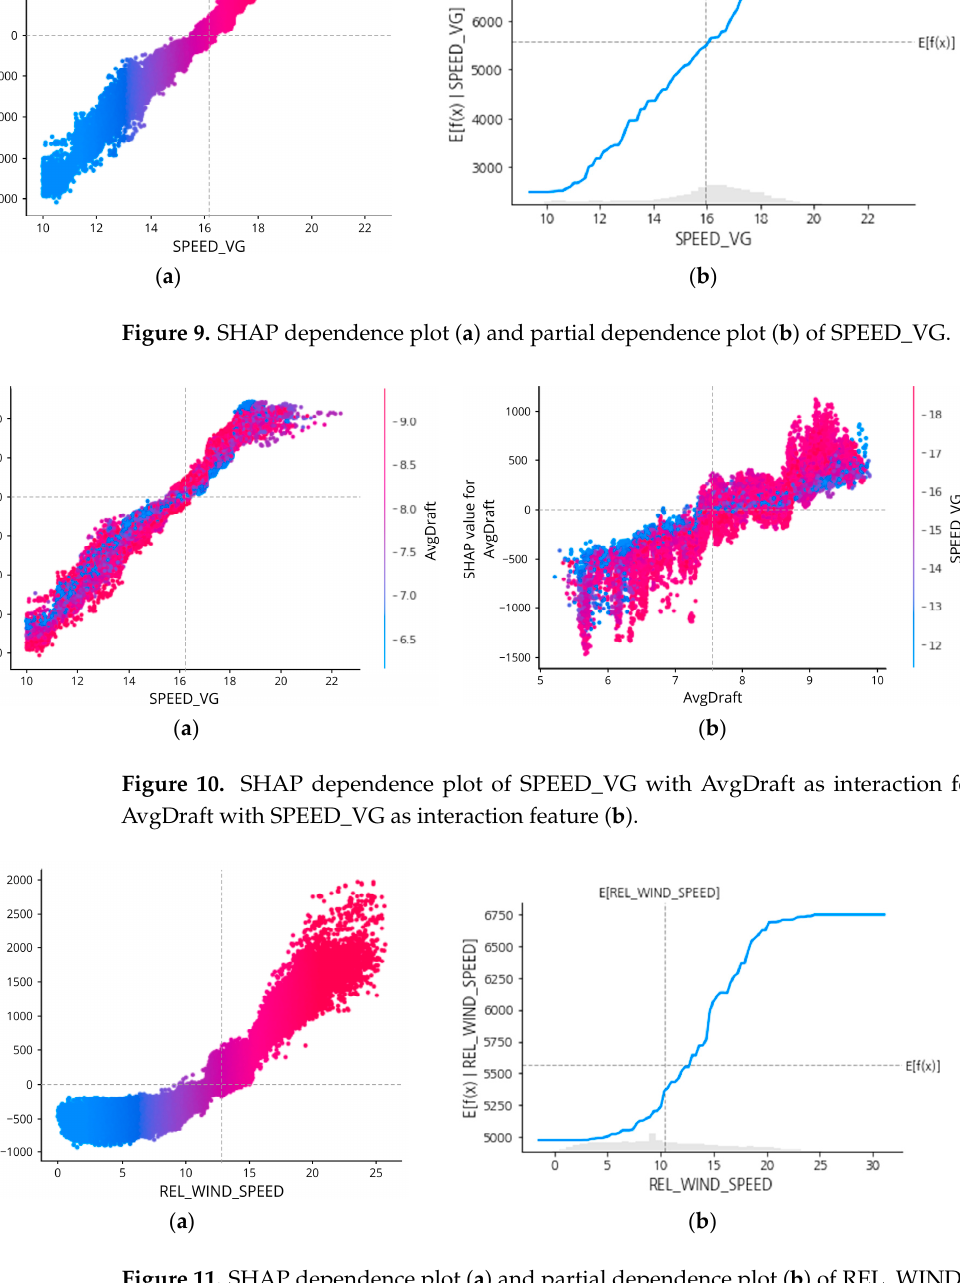
( b ) Figure 12. SHAP dependence plot ( a ) and partial dependence plot ( b ) of AvgDraft. Generally, the dependence plot showed the distribution of each feature’s Shapley value for each data instance and the red color represents high real values of the feature while blue is the opposite. Then, how the feature factual value impacts the prediction re- sult can numerically be examined using the Partial Dependence Plot that shows the ex- pected output of the prediction model. First of all, as shown in Figure 9a, the dependence plot of feature SPEED_VG showed a constant tendency which is to have higher Shapley values given the higher feature value.